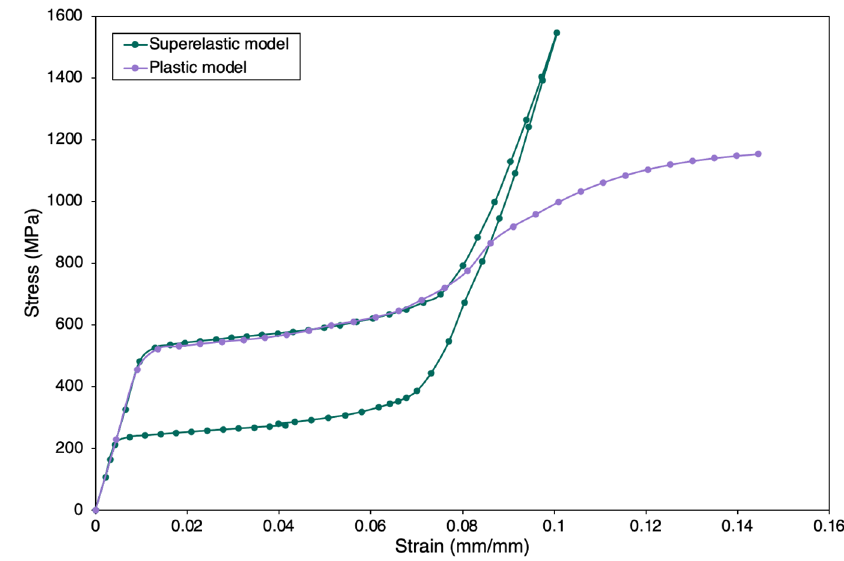
Figure 12. Discrete superelastic model and plastic model simulated results.